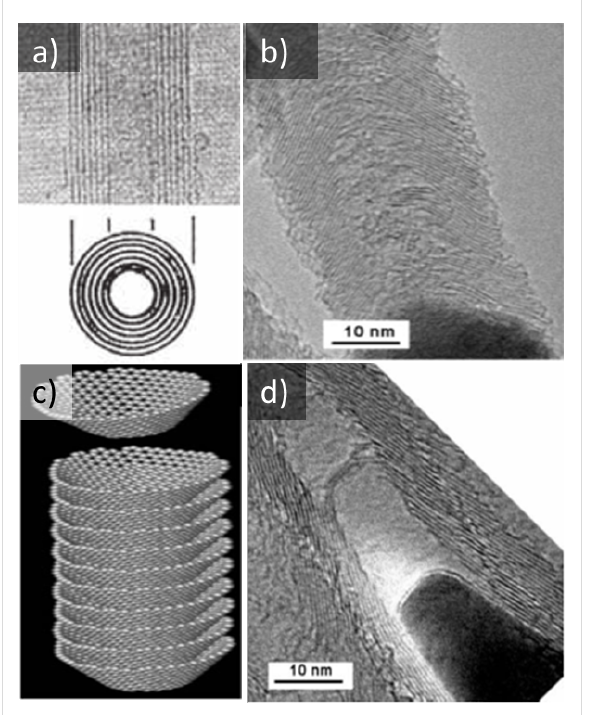
Figure 1: Images of (a) a typical MWCNT and (b,d) typical VGCNFs. A schematic representation is given in (c) of the “cup-stacked” VGCNFs, resulting in a hollow core. (a) Adapted with permission from [3], copy- right 2006 the Royal Society of Chemistry and (b,c,d) with permission from [23], copyright 2007 the Royal Society of